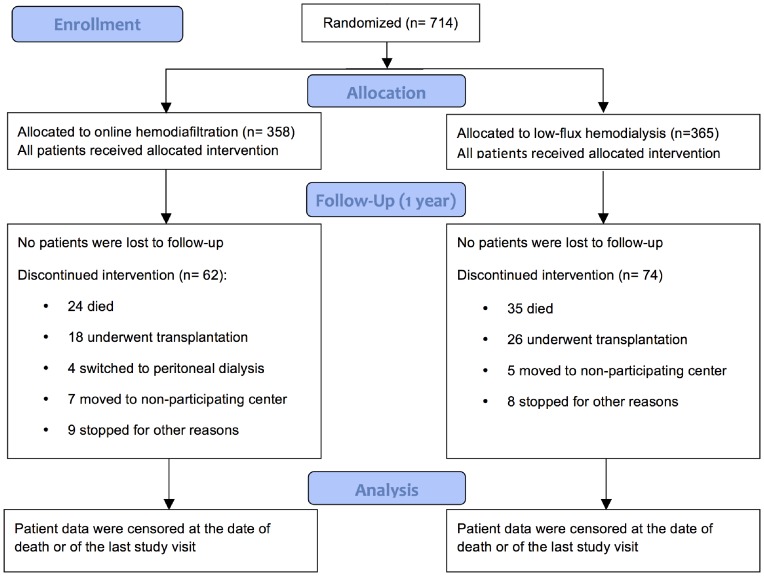
CONSORT flow chart of patient inclusion.